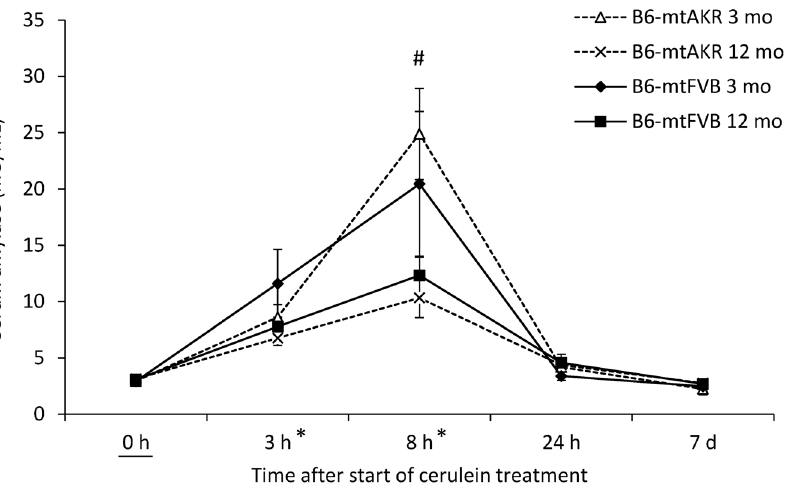
Figure 4. Measurement of a -amylase activities in B6-mtAKR and B6-mtFVB mice. Mice of two age groups (3 and 12 months, respectively; n=5–6 per time point, strain and age group) were sacrificed at the indicated time points after the start of cerulein treatment and serum samples were subjected to the analysis of a -amylase activities. Data are expressed as units per mL of serum (mean values 6 SEM). * P Dunnett , 0.001 vs. 0 h; # P